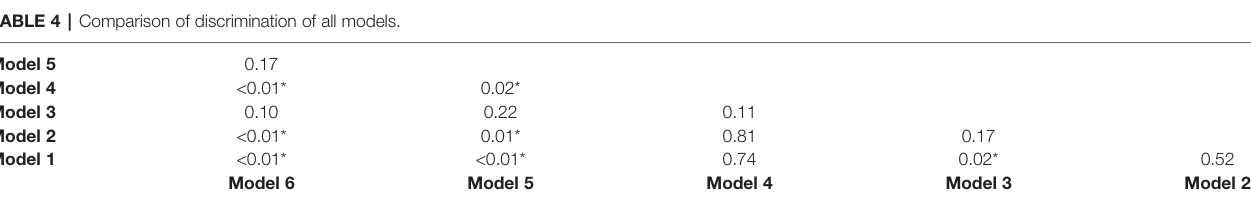
TABLE 4 | Comparison of discrimination of all models.